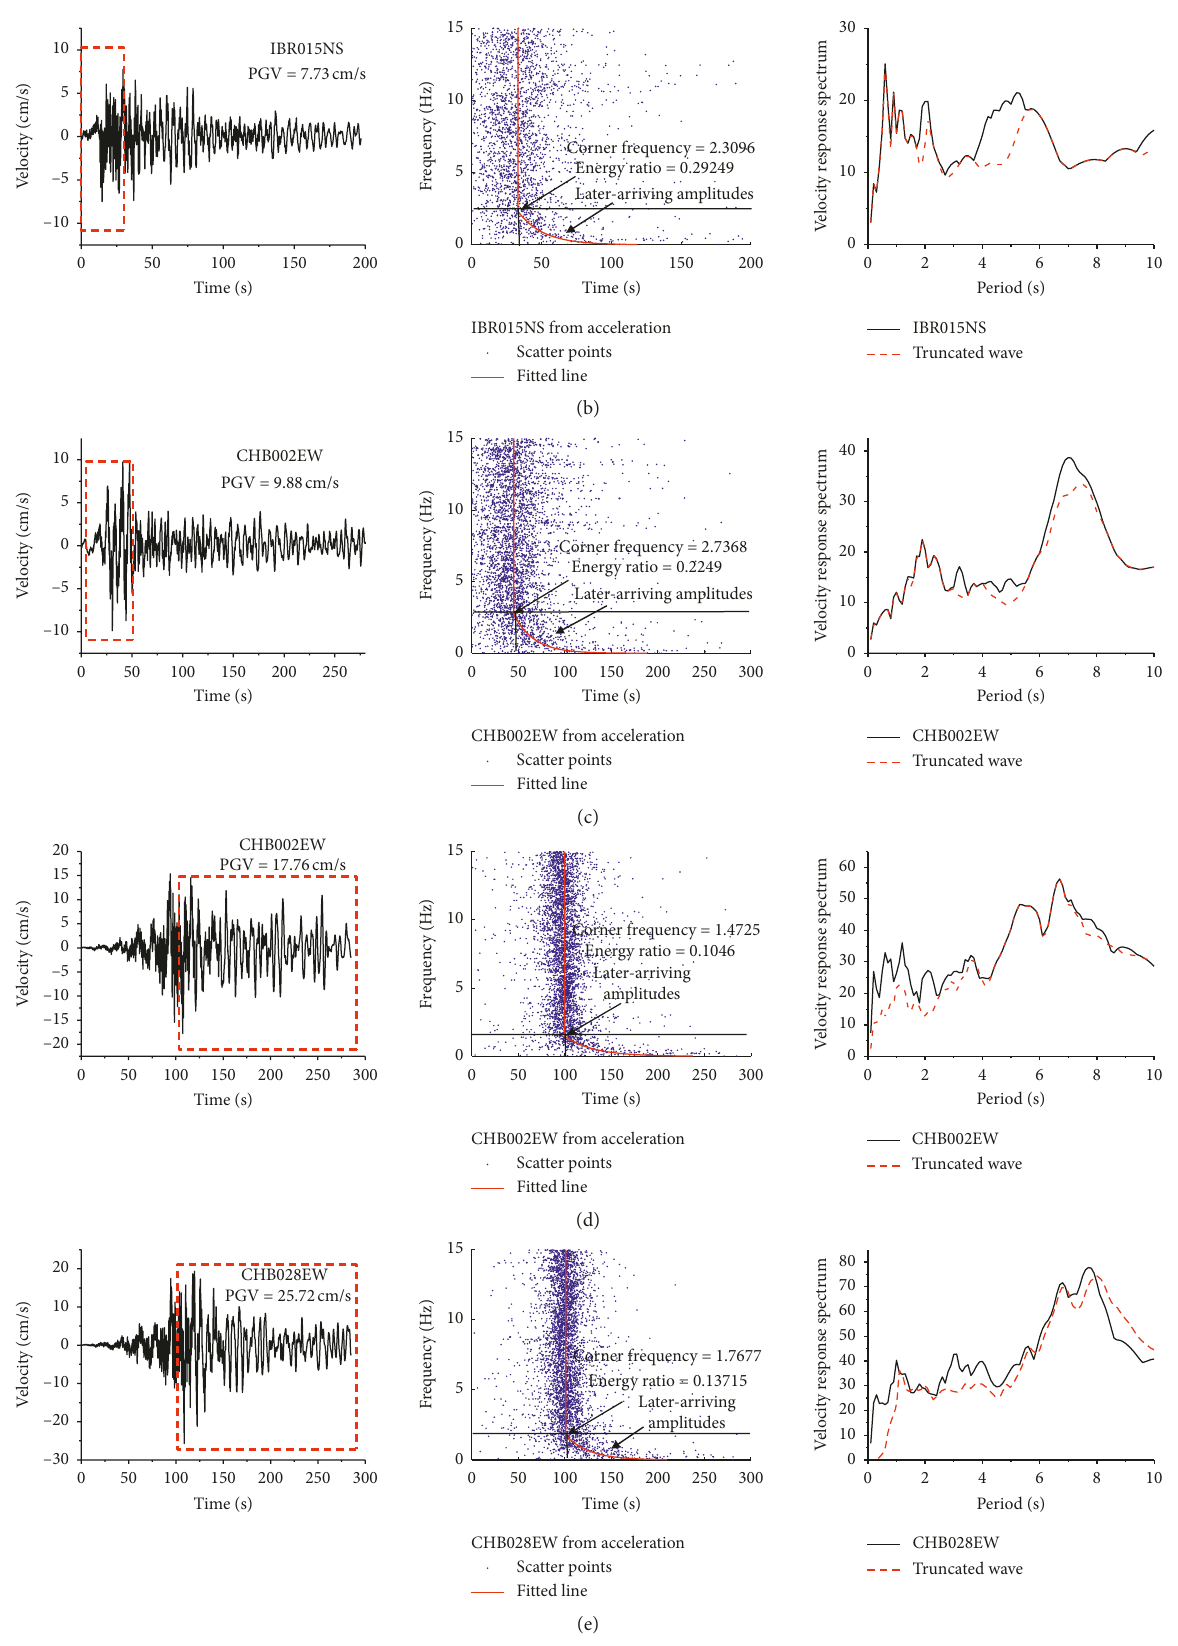
Figure 9: Five samples of false positive records; the red dashed lines shown in velocity-time histories mark the truncated waves, which are determined on the basis of envelope delays. The former three records (a)–(c) were recorded from Tohuku aftershock, M7.7, and the latter two records (d, e) were from Tohuku,